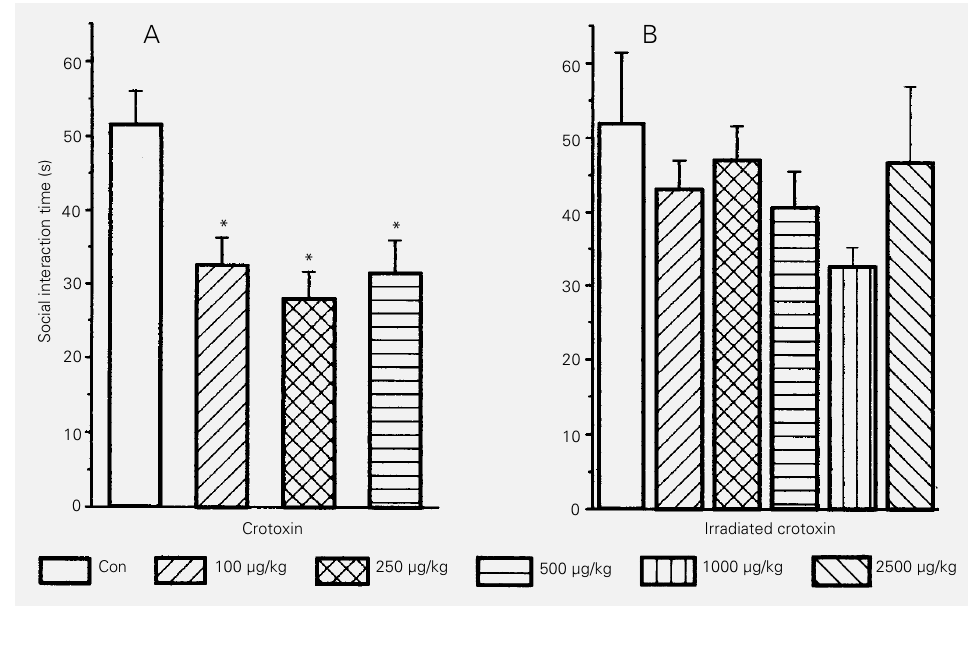
Figure 1 - Effects of crotoxin and irradiated crotoxin on rats sub- mitted to the social interaction test. Rats were injected intra- peritoneally with crotoxin (100, 250, and 500 (cid:181)g/kg) (A) or irradi- ated crotoxin (100, 250, 500, 1000, and 2500 (cid:181)g/kg) (B) or sa- line 2 h before the social inter- action test. Data are reported as the mean – SEM for 6 pairs of animals per group. *P<0.01 compared to control (dose zero) (Dunnett test).